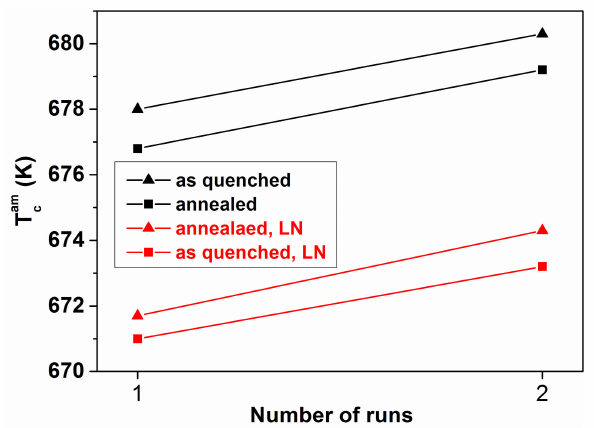
Figure 19. Curie temperature T Cam of Fe 78 Ni 5 B 16 samples in as-quenched state and after heat treatment during two subsequent measuring runs. Both kinds of samples were previously treated at liquid nitrogen (LN) temperature (77 K) (superposition of di ff erent thermal history). Adopted from [60], with permission from IOP publishing,